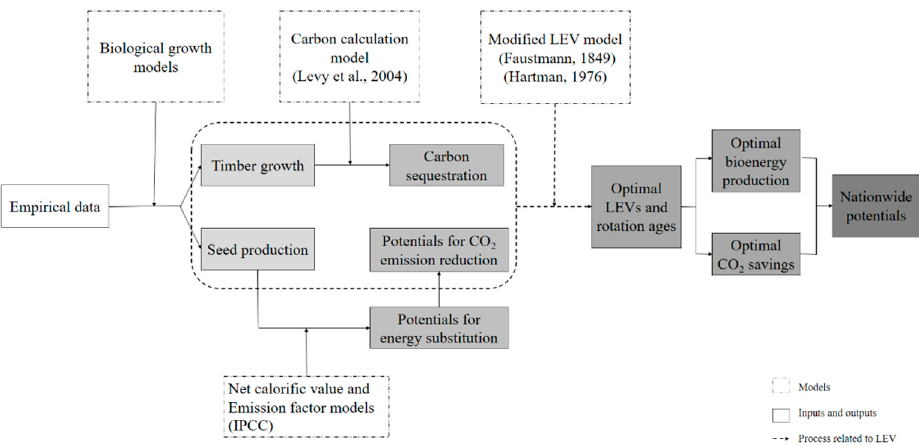
Figure 1. The structure of models and the inputs and outputs of each stage in and their relationships.